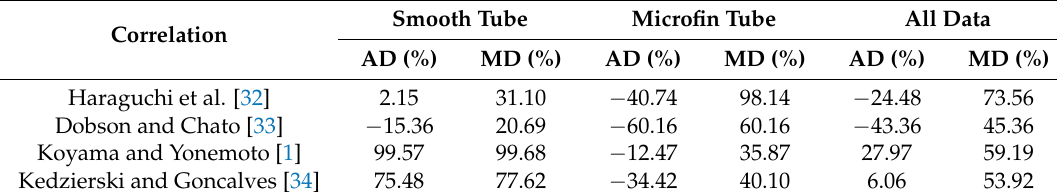
Table 6. Deviations of condensation heat transfer coefficient.